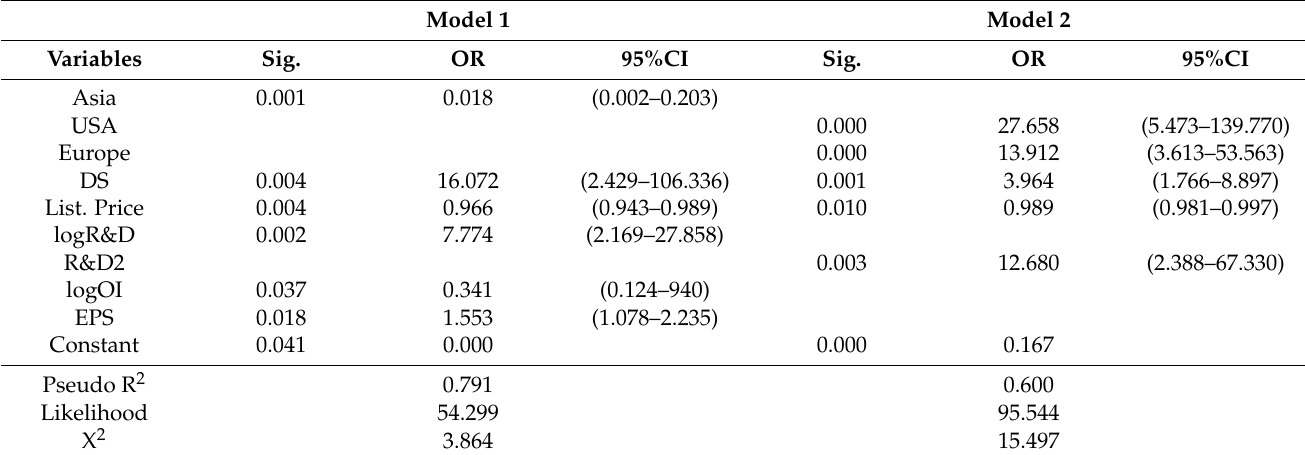
Table 4. The binomial logistic regression results for the Merco pharmaceutical reputation